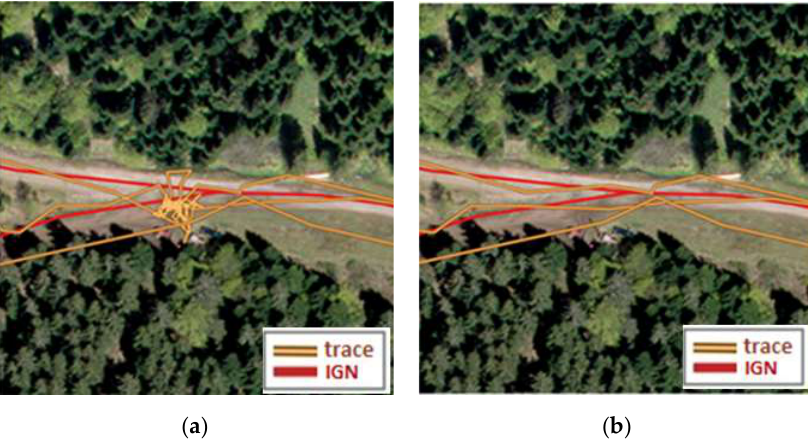
Figure 7. Typical GNSS traces: ( a ) Before and ( b ) after SHB filtering.